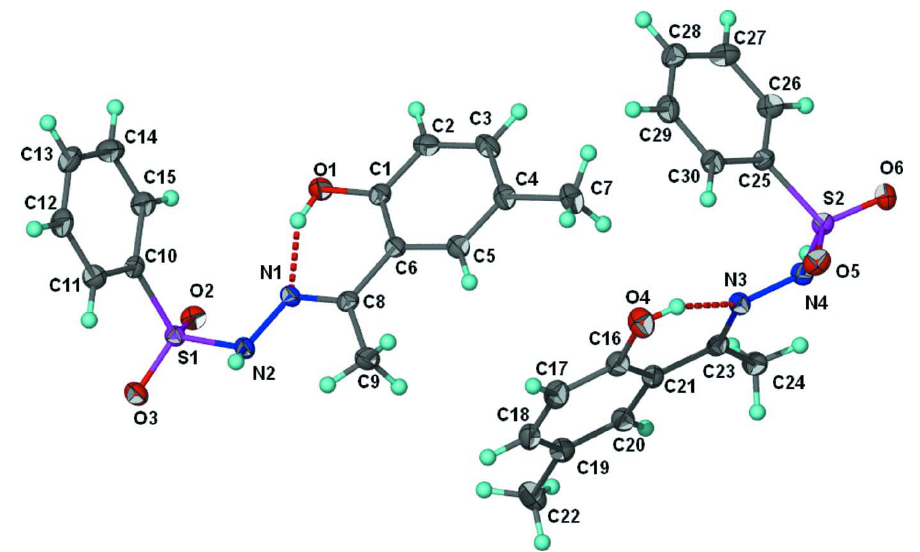
Thermal ellipsoid plot of the asymmetric unit of (I) (Barbour, 2001) at the 70% probability level. Dashed line indicates